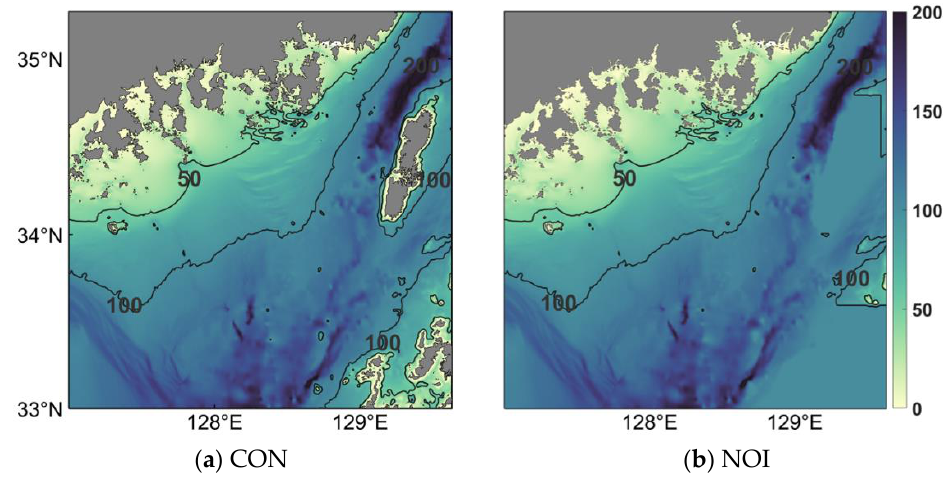
Figure 8. Spatial distributions of bottom depth (m) for ( a ) the control (CON) experiment and ( b ) no offshore islands (NOI) experiment. The contour intervals of the isobaths are 50 m.